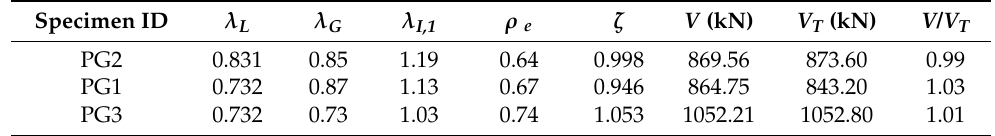
Table A16. Analysis results of test specimens reported by Moon et al.